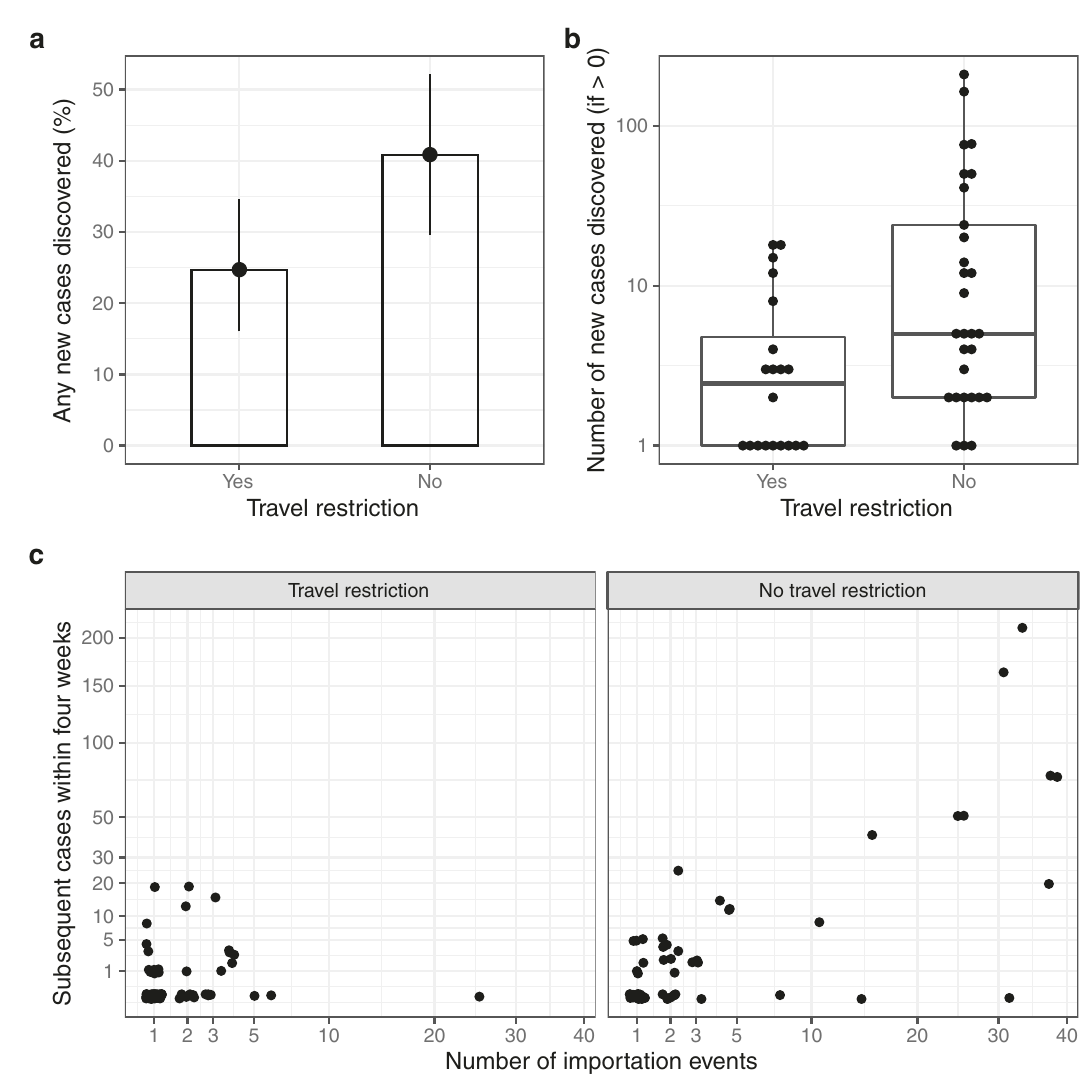
Fig. 4 The effect of travel restrictions (14-day quarantine) on the subsequent spread of likely imported cases as determined by genomics. a The proportion of imported cases with any matching genome detected over the four weeks following index test result. Error bars correspond to bootstrapped con fi dence intervals, n = 81 and 71. b The number of genomes matching the index case, with zeros excluded. The midline of the boxplot represents the median value; the lower limit of the box represents the fi rst quartile (25th percentile), and the upper limit of the box represents the third quartile (75th percentile); the whiskers (upper and lower) extend to the largest and smallest value from the box, no further than 1.5*IQR from the box. a , b Compare countries with travel restriction guidance (closed ‘ travel-corridors ’ ) in place and those without (open ‘ travel-corridors ’ ). c The number of cases and number of importation events for each imported genome, strati fi ed by whether the index case had returned from a country with a travel restriction in